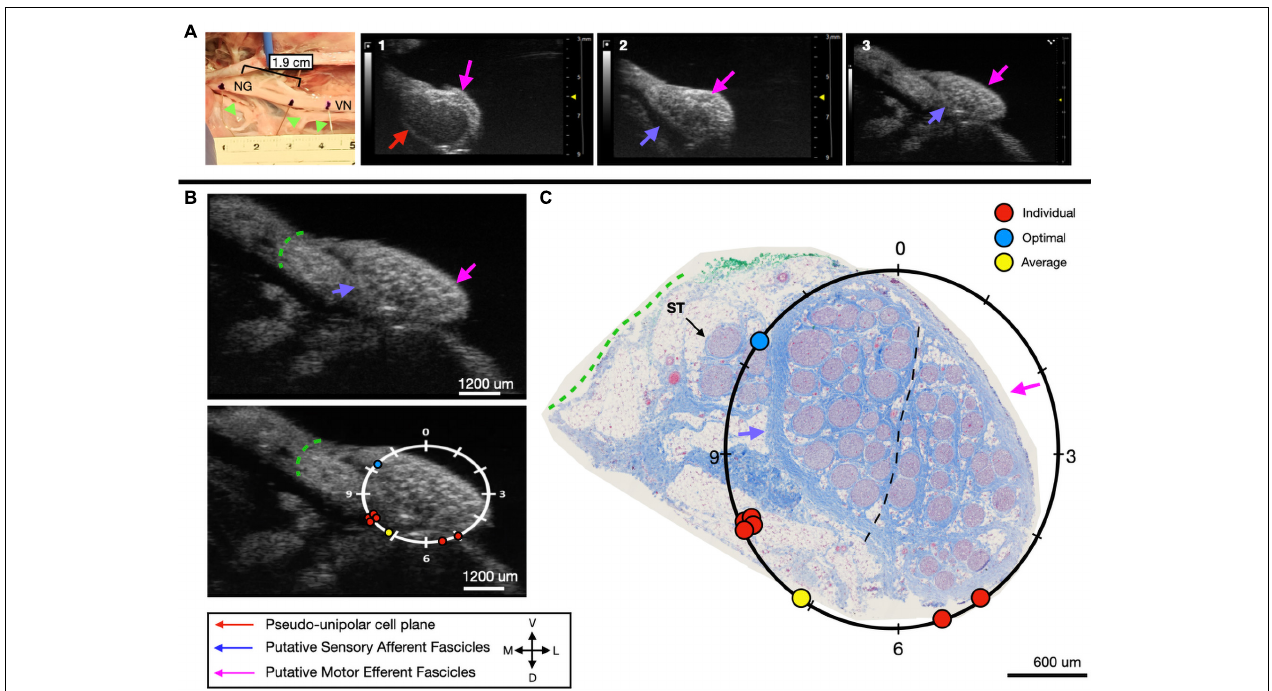
FIGURE 7 | Subject 3 (A) From Left to Right: Location of wire fiducials and histology dye within the surgical pocket. The location of the paired ultrasound video and required placement of stimulating contact is at wire fiducial two [1.9 cm from the superior laryngeal coming off of the nodose ganglion (NG)]. (A1–3) Progressive ultrasound images in the cranial to caudal direction from the NG to the cervical vagus nerve (VN), and location where volunteers were requested to place the stimulating contact (1–3, respectively). Red arrow indicates pseudo-unipolar cell region of the NG, pink arrows indicate motor efferent region, purple arrow indicates sensory afferent region, as confirmed via histology. (B) Ultrasound cross sections of wire fiducial two, where volunteers were asked to trace the sensory afferent axons from the NG. Top panel: pink arrows note motor efferent region, purple arrow indicates the sensory afferent fascicle grouping, green dashed line indicates area of transected connective tissue during removal for histology. Bottom panel: analog clock face placed on test video to give volunteers locations to place the hypothetical stimulating contact based on their tracing task, green dashed line indicates area of transected connective tissue during removal for histology. (C) Histology slice from wire fiducial two, as indicated with histology dye, with analog clock face to demonstrate stimulating contact locations as placed by volunteers in the ultrasound video. Green dashed line indicates area of transected connective tissue during removal for histology. (B,C) Red circles indicate each volunteer’s placement of the stimulating contact, the yellow circle indicates the average response, and the blue circle indicates the optimal contact location. Sympathetic trunk (ST), medial (M), ventral (V), lateral (L), dorsal